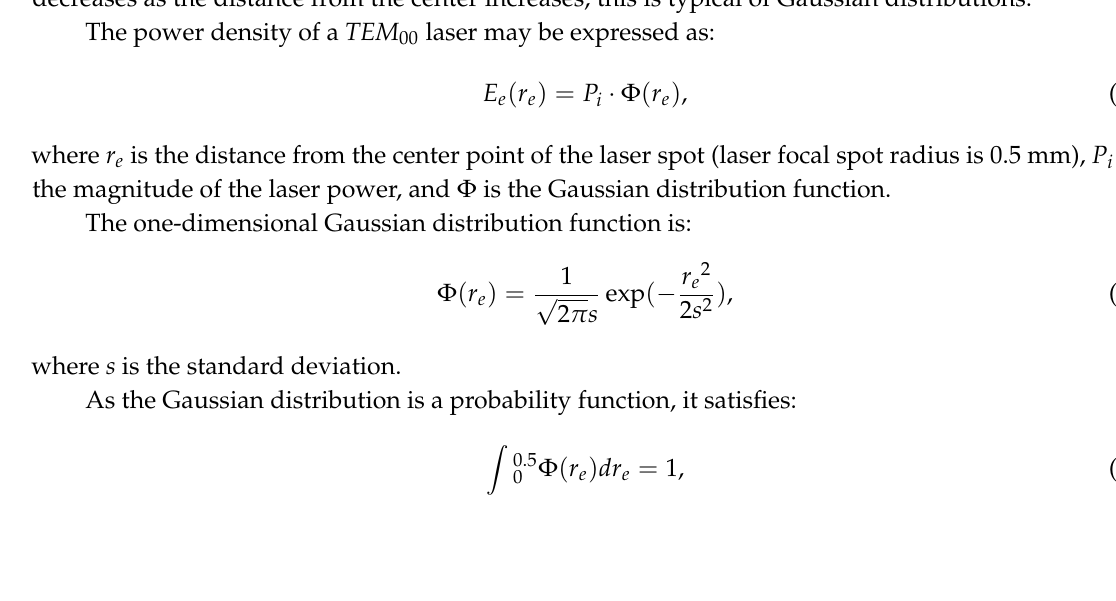
Figure 3. The temperature dependent material properties of AISI 4140. ( a ) Young’s modulus; ( b ) Coefficient of thermal conductivity; and ( c ) Specific heat.